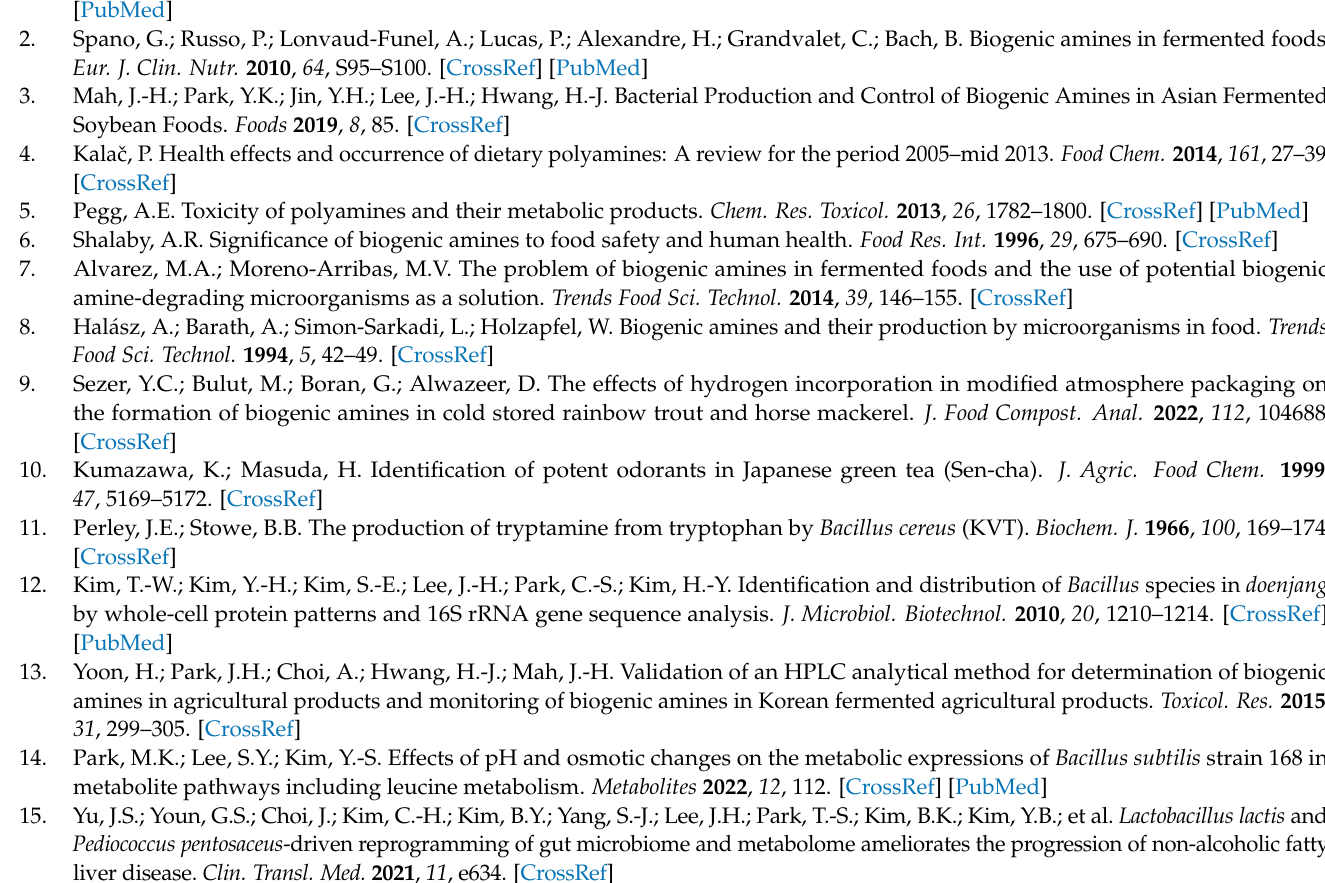
Table S3: Non-volatile metabolites identified in Bacillus subtilis . Table S4: The changes of amino acid precursors and BAs according to cultivation